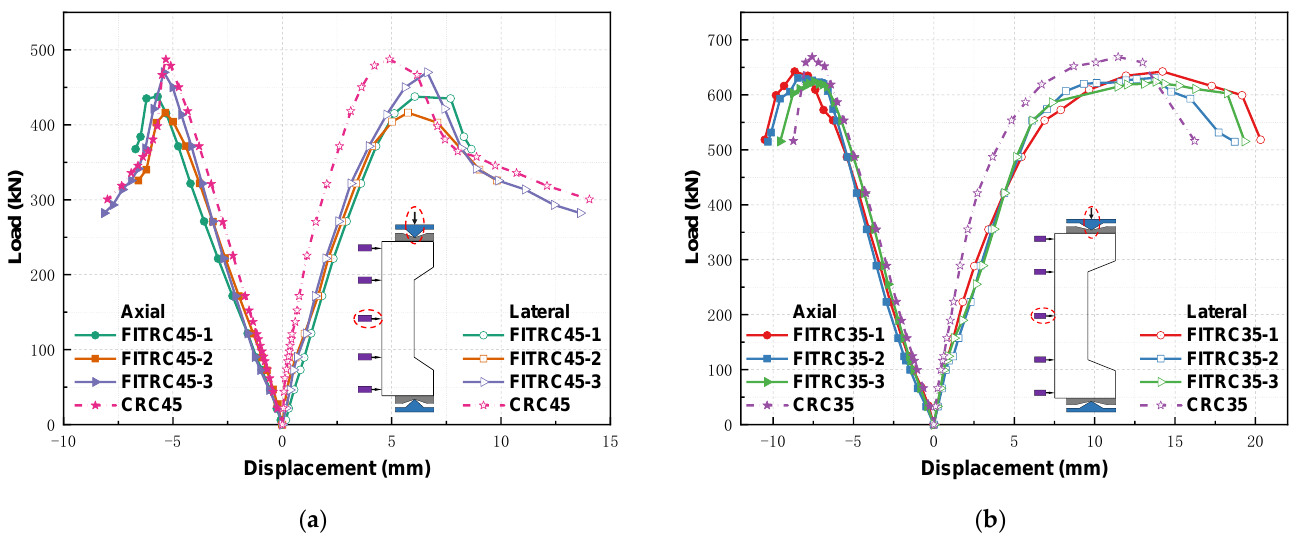
Figure 10. Load–deflection curves of RC columns: ( a ) e 0 / h 0 = 0.60; ( b ) e 0 / h 0 = 0.70. Table 8. Main performance indices of RC columns.